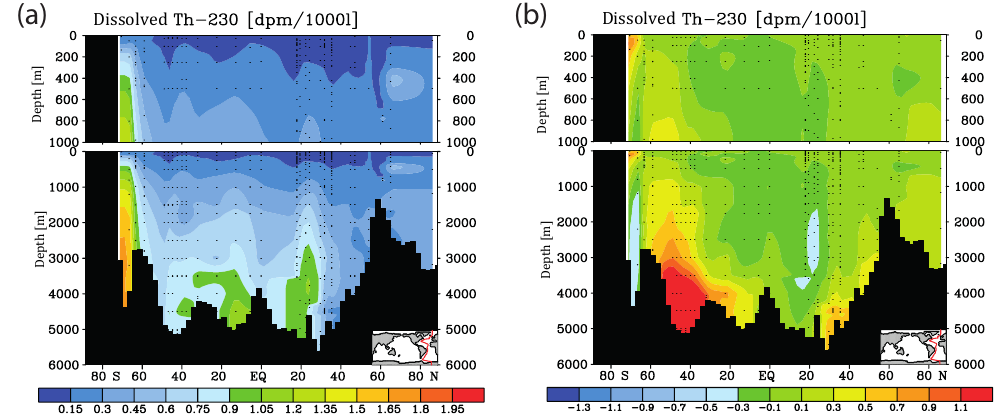
Figure 4. Meridional dissolved 230 Th Atlantic Ocean cross sections in dpm/1000L (dpm indicates disintegration per minute): (a) interpola- tion from observations (data from the GEOTRACES intermediate data product; for references, please see the text). (b) Difference between the model values from the control run without CO 2 emissions and the